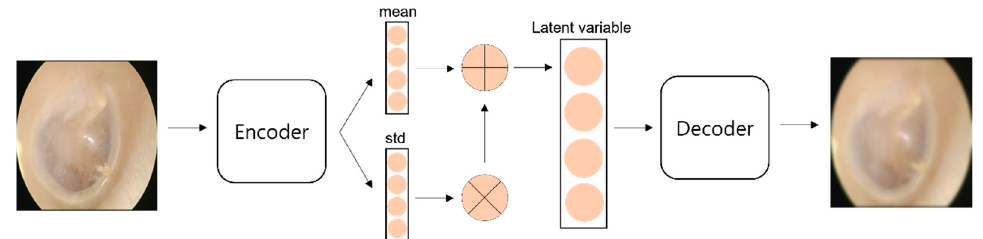
Figure 8. Architecture of